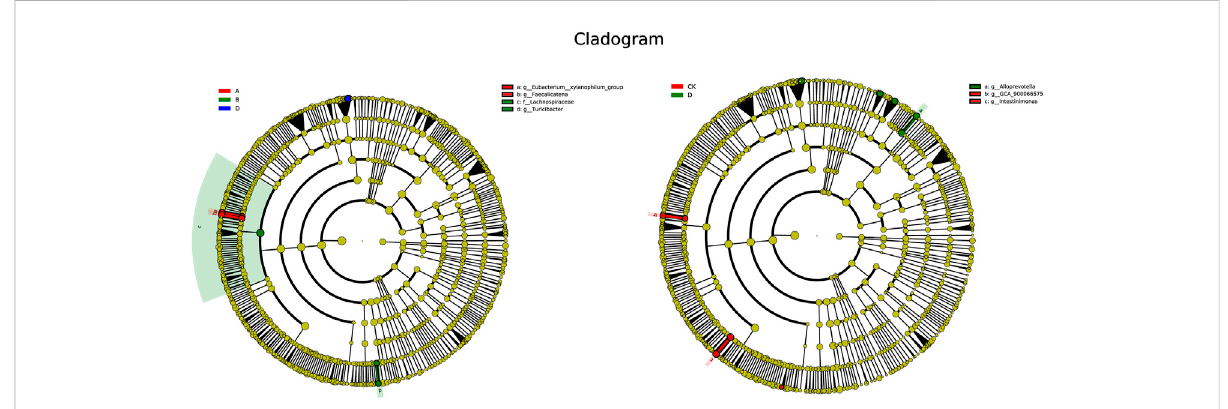
FIGURE 8 LEfSe multi-level species hierarchy tree. The nodes with different colors corresponding to the groups in the fi gure indicate signi fi cant enrichment in this group, and the microbial community has a signi fi cant impact on the differences between groups. The nodes marked in yellow indicate the microbe groups that have no signi fi cant difference among different groups. A, L-APS; B, M-APS; CK, H-APS; D,